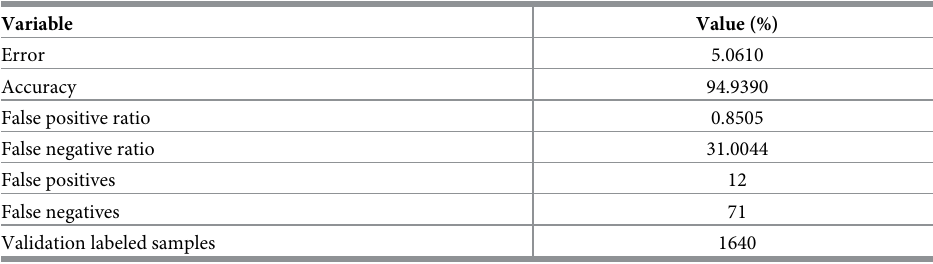
Table 8. Performance of the